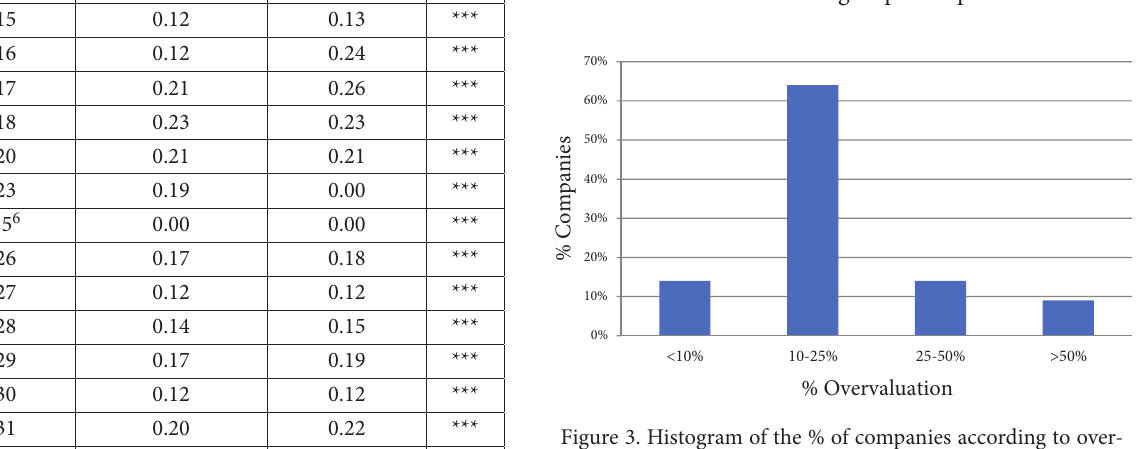
Figure 3. Histogram of the % of companies according to over- valuation Table 7. Distribution of appraisal companies according to number of appraisals made,